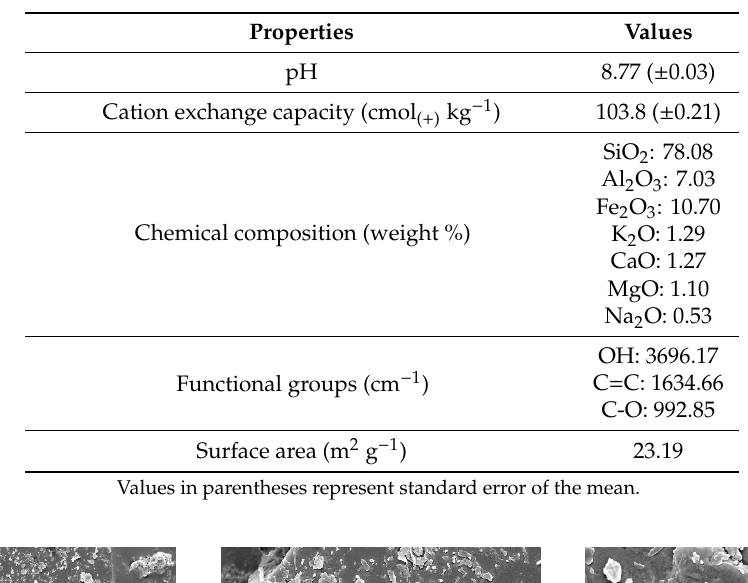
Table 3. Selected chemical and physical properties of clinoptilolite zeolite.